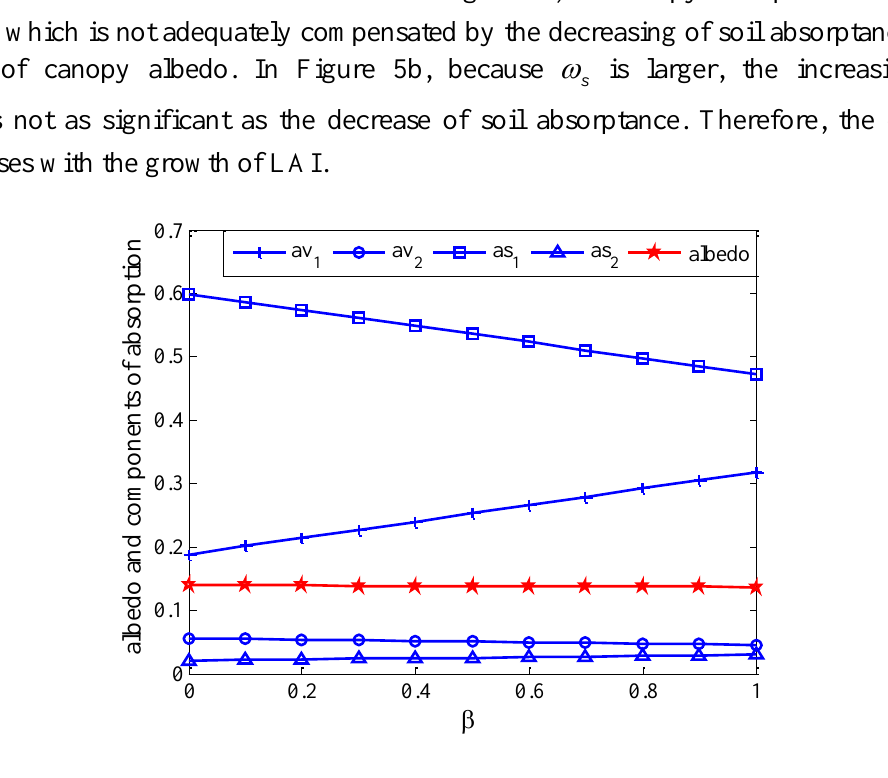
Figure 5. The determinants of the canopy albedo as functions of LAI: ( a )  = 0.7 (near-infrared band), 0.22, h    ; ( b ) band), 0.22, h r  20 l s g